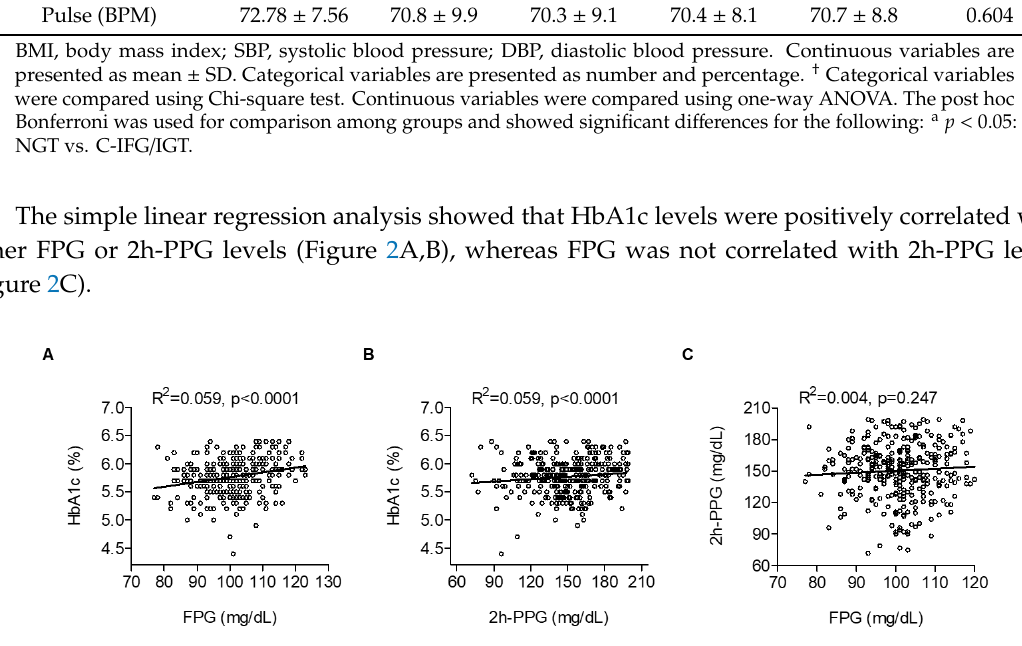
Table 3. Biochemical characteristics among prediabetes subtypes.